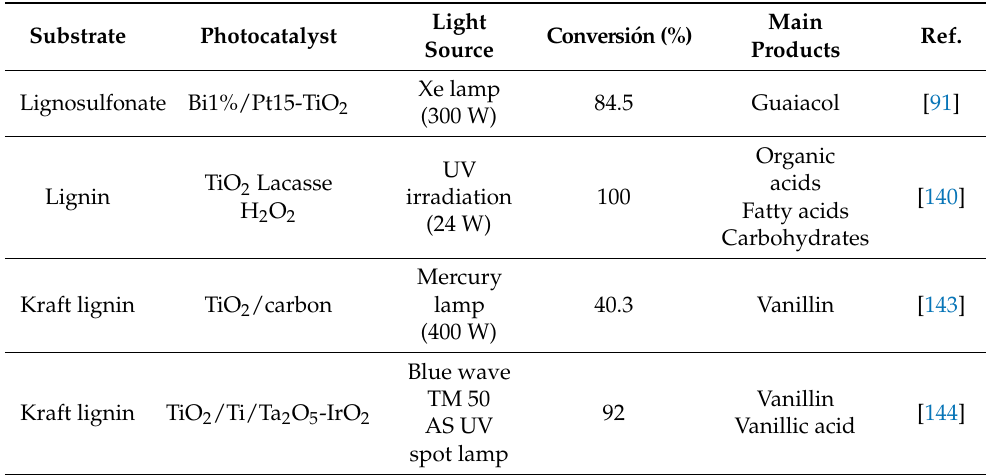
Table 4. Summary of results of the photocatalytic conversion of lignin and its deriv-